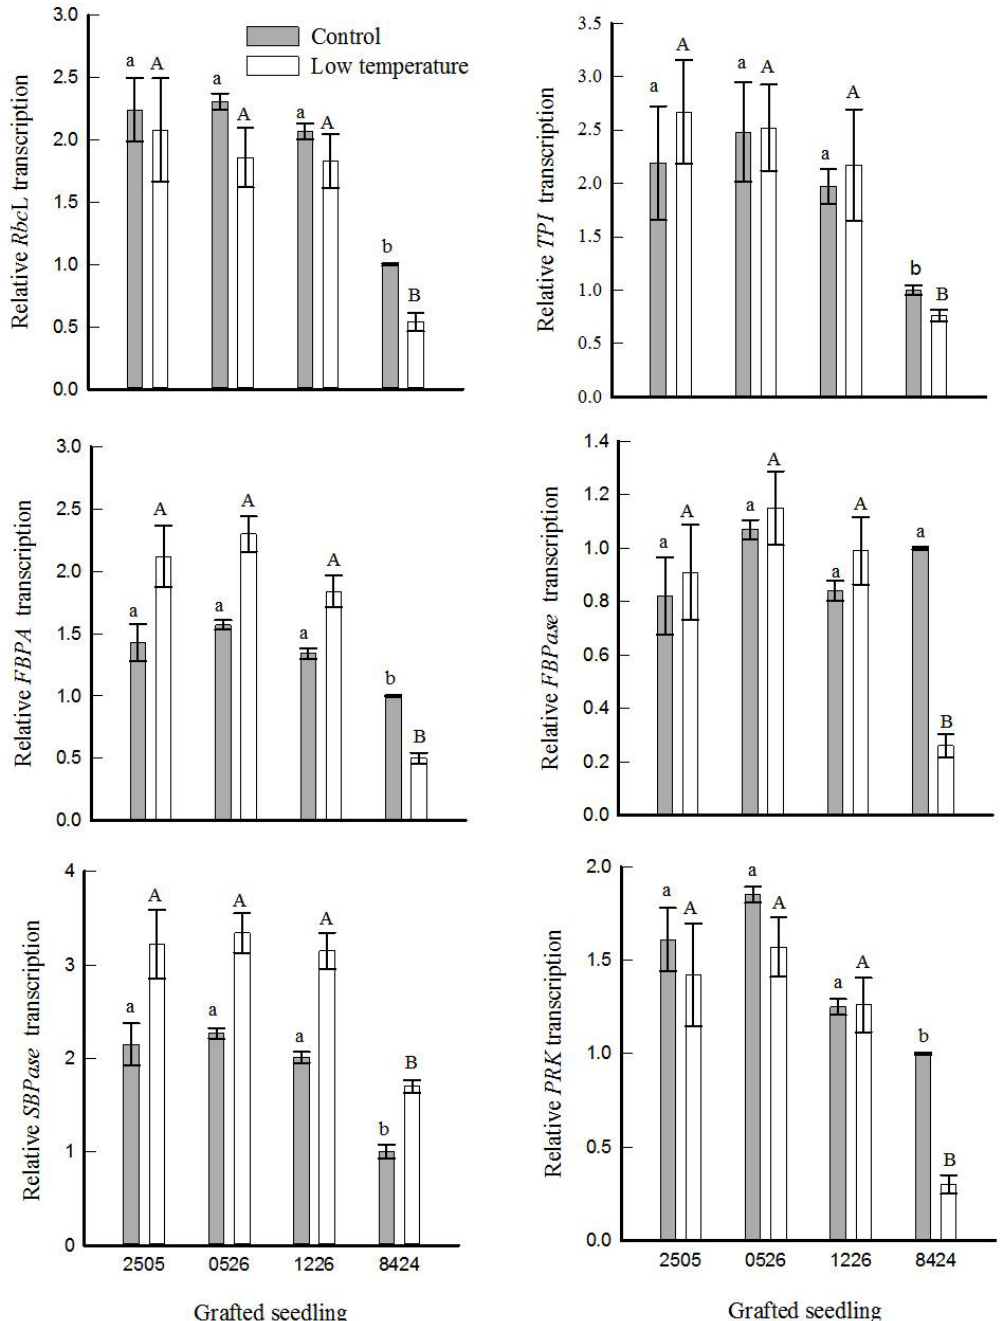
Figure 6. qRT-PCR analysis of the studied genes. Total RNA was extracted from scion leaves, converted to cDNA, and subjected to comparative real-time RT-PCR quantification. Relative transcript levels from qRT-PCR are the mean ± SE of three replicates. Bars with different letters indicate a significant difference ( p < 0.05).